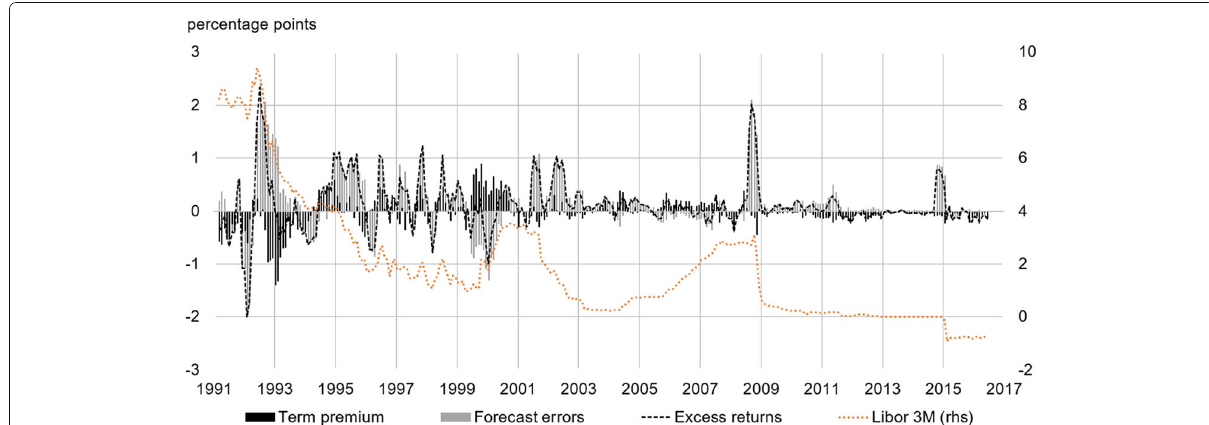
Fig. 2 Decomposition of excess returns (3-month maturity). The figure shows the development of excess returns with an end of month maturity in 3 months (black dashed line) and its decomposition. The term premium is depicted in black bars, and forecast errors are depicted in gray bars. The dataset contains monthly observations for LIBOR futures and interest rate surveys from March 1991 through August